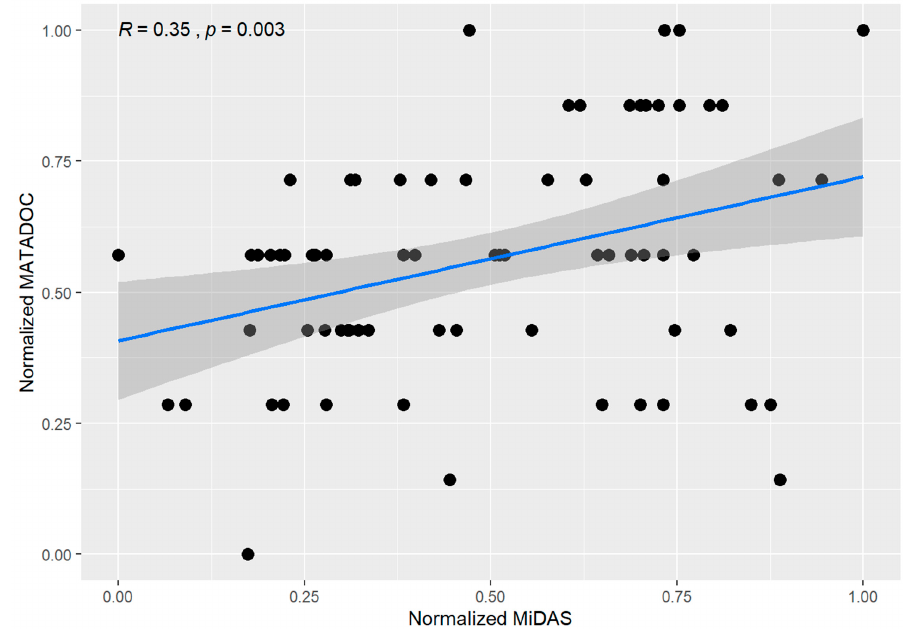
Figure 1. Correlations for MATADOC and MiDAS scores by patient, rater, session, and condition (live/video).